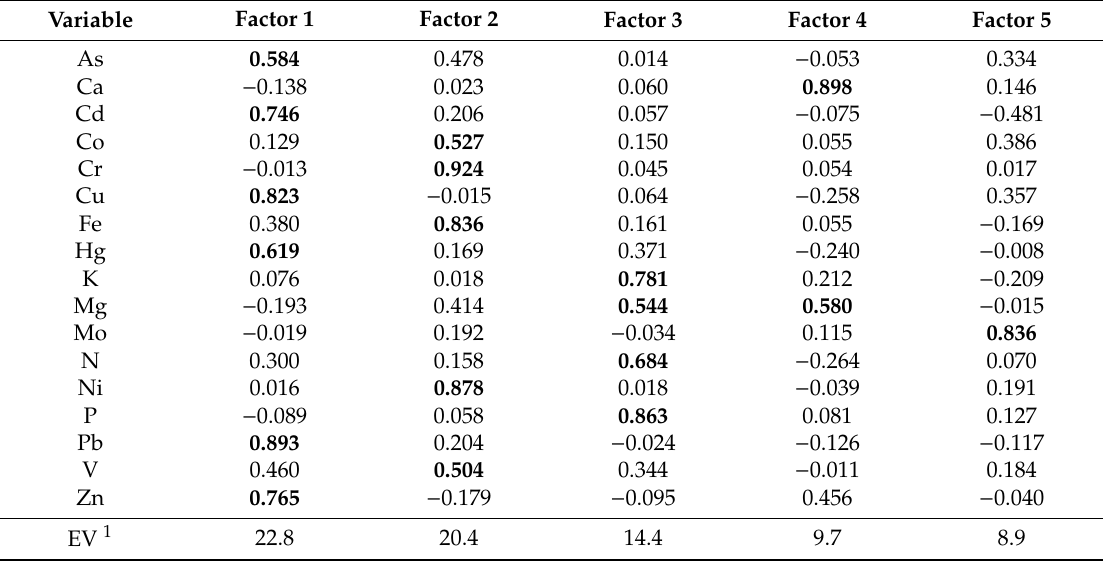
Table 2. Factor loadings (varimax-rotated) of element concentrations in moss determined by a factor analysis for 117 sampling sites in 2015. Loadings greater than 0.5 are in